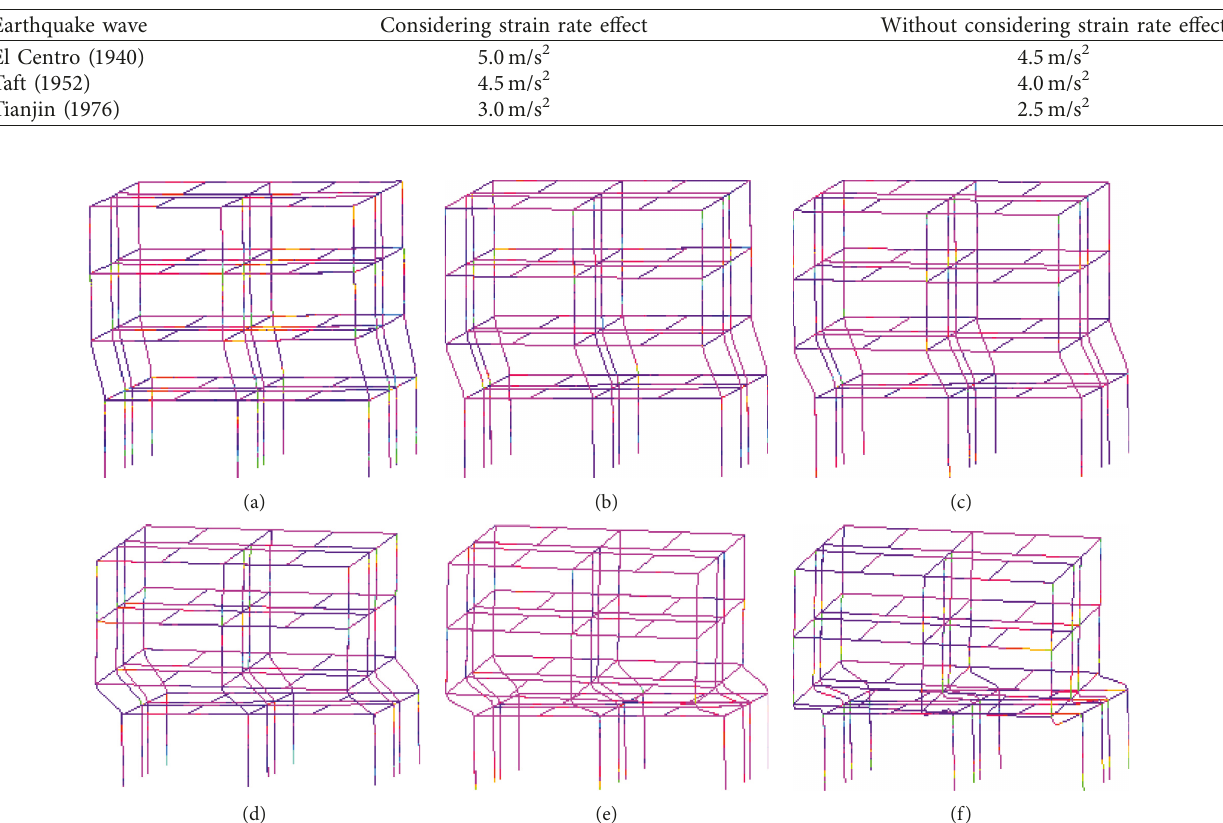
Table 5: Collapse-resistant capability of the RC structure subjected to three-component directional excitation.